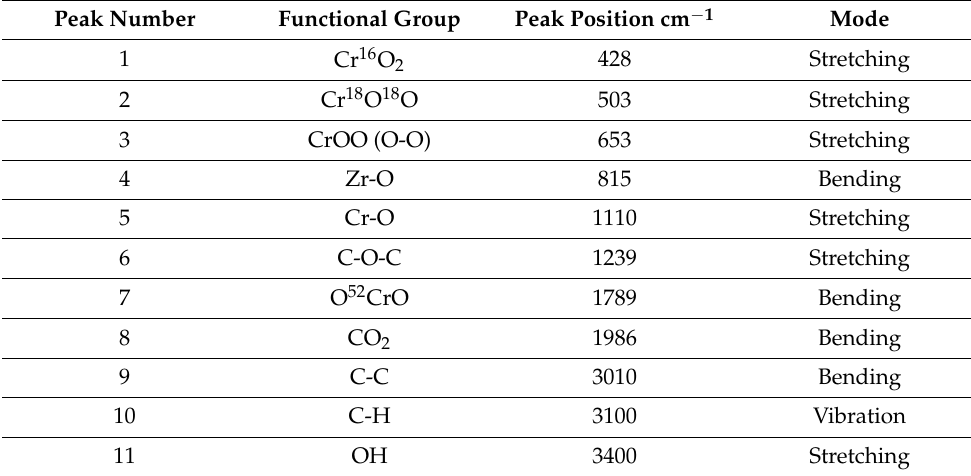
Table 1. FT-IR studies of Zr-doped CrO 2 photocatalysts.